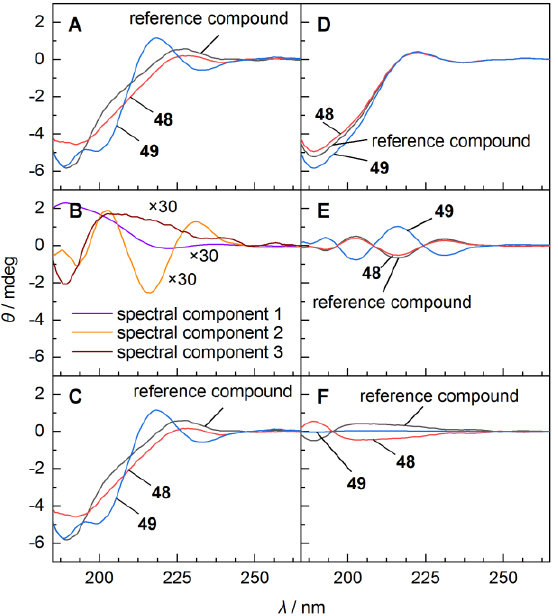
Figure 3. Circular dichroism (CD)-based identification of the absolute configuration of the dimethyl- ated Tyr 11 in 48 and 49 through spectral deconvolution and assignment of linearly independent spectral features to stereochemical and structural properties. ( A ) CD spectra of the two diastere- omers 48 and 49 and an all- ʟ -reference compound (Me-Arg-Arg-Pro-Tyr-Ile-Leu [40] ). ( B ) Linearly independent components (“abstract spectra”) from SVD, shared by the two diastereomers and the reference compound (rescaled by a factor of 30 for better comparison). ( C ) Reconstruction of full spectra from linear combination of the “abstract spectra” in panel B. ( D ) Contributions of component 1 to the full spectra in A or C correlating with CD contributions from the peptide backbone minus contributions from the fourth amino acid (tyrosine in the reference compound or β , β -dimethylated tyrosine in 48 and 49 ). ( E ) Contributions of component 2 correlating with the configuration at the α -carbon of the fourth amino acid. Identical signs of the bands of this spectral component indicate the same configuration in 48 and the reference compound. ( F ) Contributions of component 3 accounting for spectral differences due to β , β -dimethylation that have not been considered in component 1 and component 2. As the SVD factorizes the experimental spectra with respect to highest spectral agreement, i.e., a ‘compromise’ spectrum formed from the spectra of the reference compound, 48 and 49 , absence of β , β -dimethylation in the reference compound is reflected by a negative contribution of component 3.